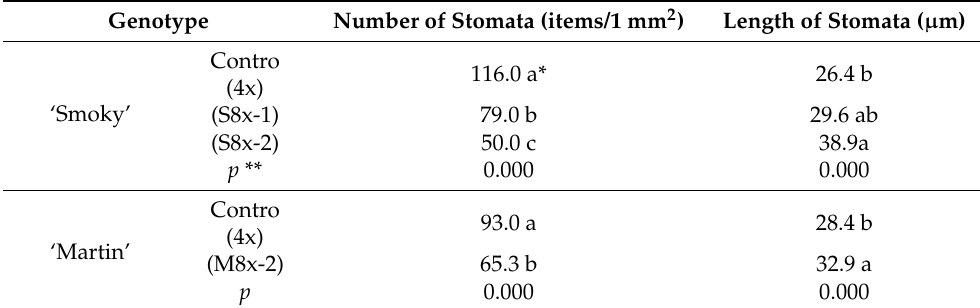
Table 5. Number and length of stomata in Amelanchier alnifolia cvs. ‘Smoky’ and ‘Martin’ tetraploid (4x) and octoploid (8x)